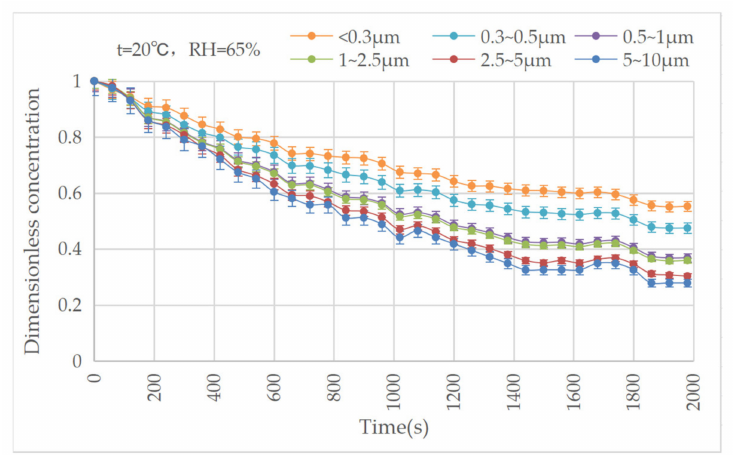
Figure 5. Evolution of particle concentrations in 20 ◦ C, RH =